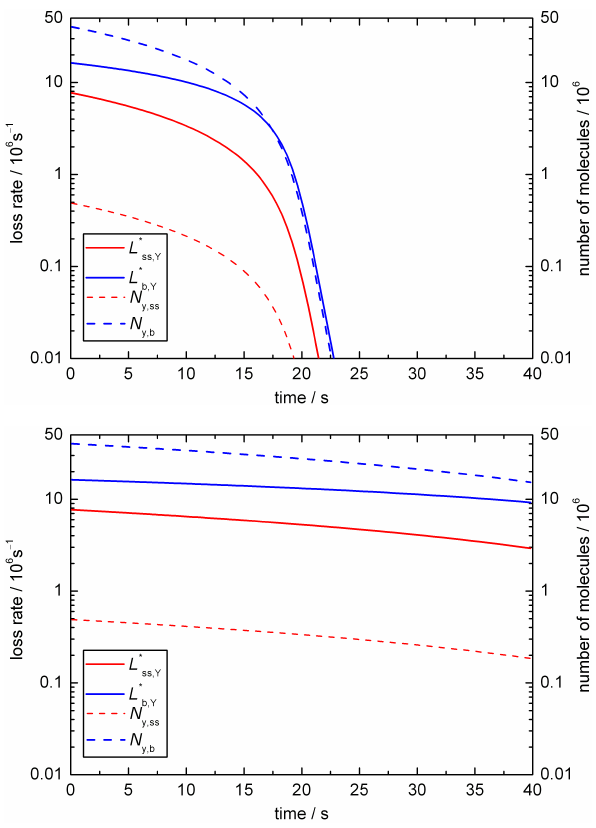
Fig. 6. Temporal evolution of aerosol particle composition and kinetic parameters in sensitivity studies for BC1 for (a) doubling and (b) halving α s , 0 , X (while compensating with k d , X to maintain agreement with the experimental Henry’s law coefficient H cp , X ) . Plots are analogous to Fig.